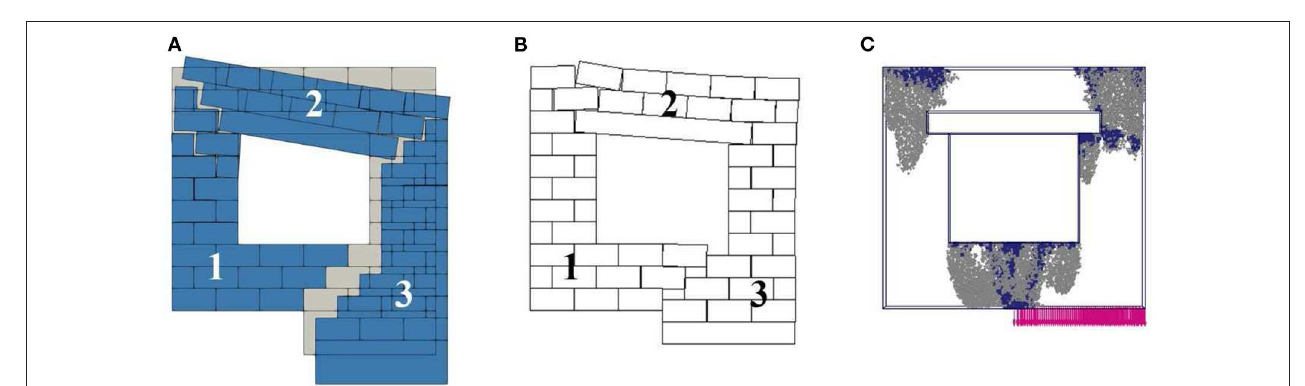
FIGURE 9 | (A) LA, (B) FEM/DEM, and (C) FEM results for Panel 2 case.